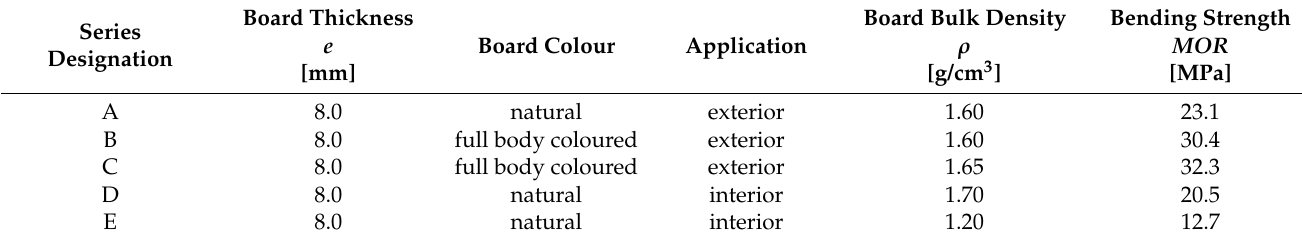
Table 1. Tested fibre-cement boards of series A to E and their basic